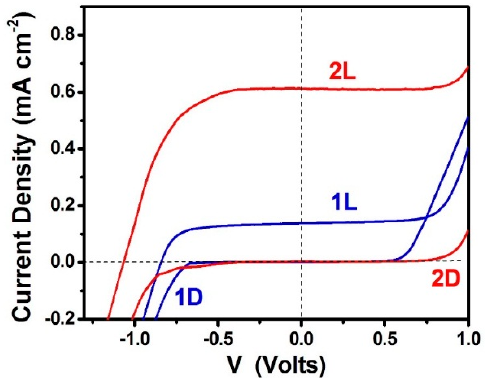
Figure 3. Current density-Voltage curves obtained with a PFC functioning in the presence of oxygen. The aqueous electrolyte always contained 0.5 mol·L − 1 NaOH without (curve 1) or with (curve 2) 5 v % ethanol. L signifies irradiation (Light) and D dark. In both cases